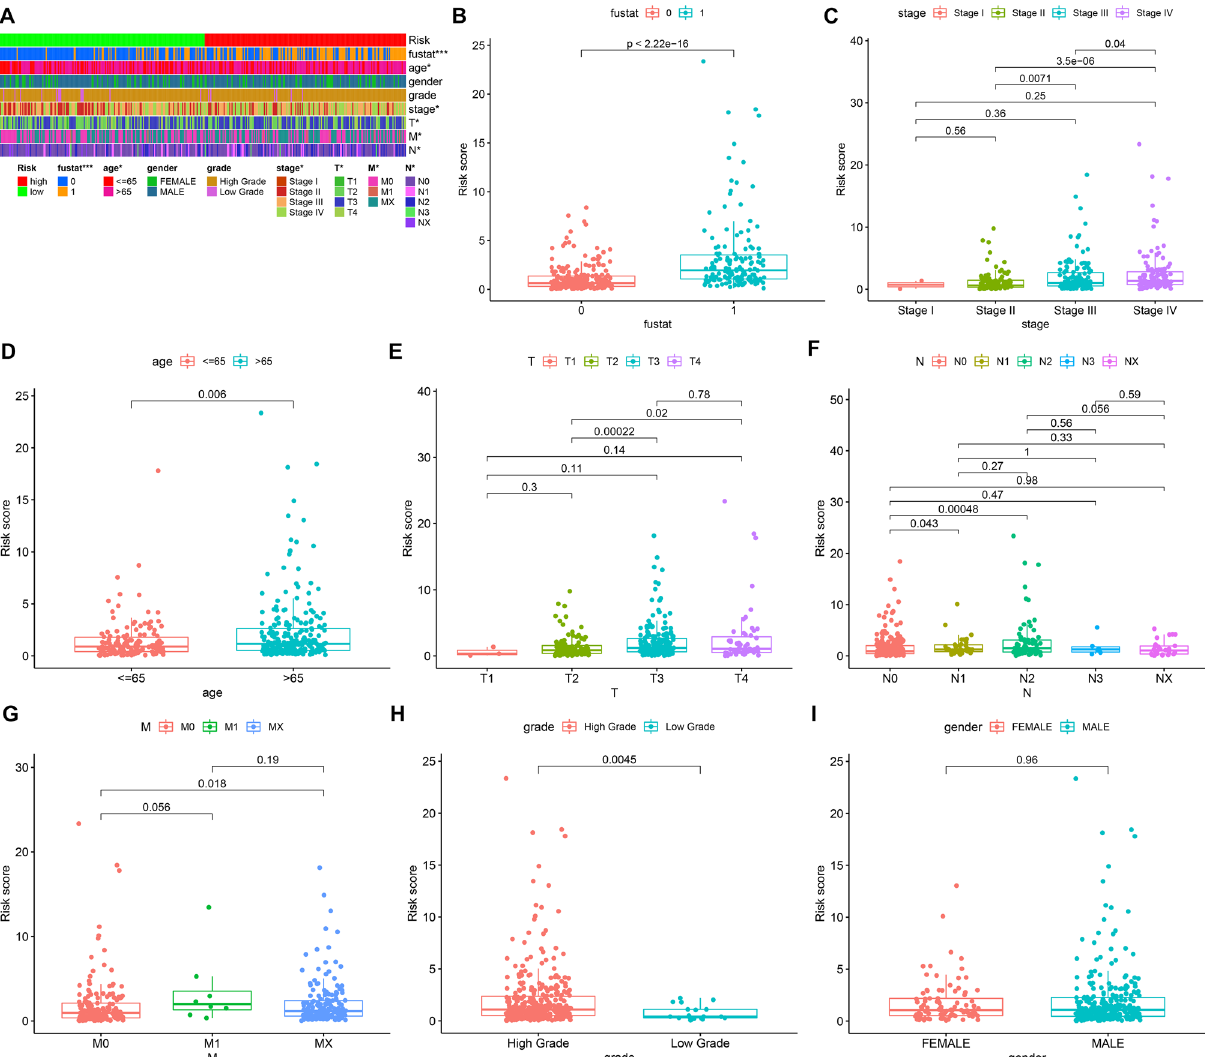
Figure 4. Associations between this prognostic immune-related lncRNA signature and clinicopathological characteristics of bladder cancer. ( A ) Heatmaps of the visualization of clinicopathological characteristics: survival status, age, gender, grade, stage, T, N and M in high and low bladder cancer subjects. *p < 0.05; ***p < 0.001. Comparing the risk score in different clinicopathological characteristics: ( B ) survival status (0: dead; 1: alive), ( C ) stage I–IV, ( D ) age ≤ 65 and > 65, ( E ) T1–4, ( F ) N0-X, ( G ) M0-X, ( H ) grade and ( I )